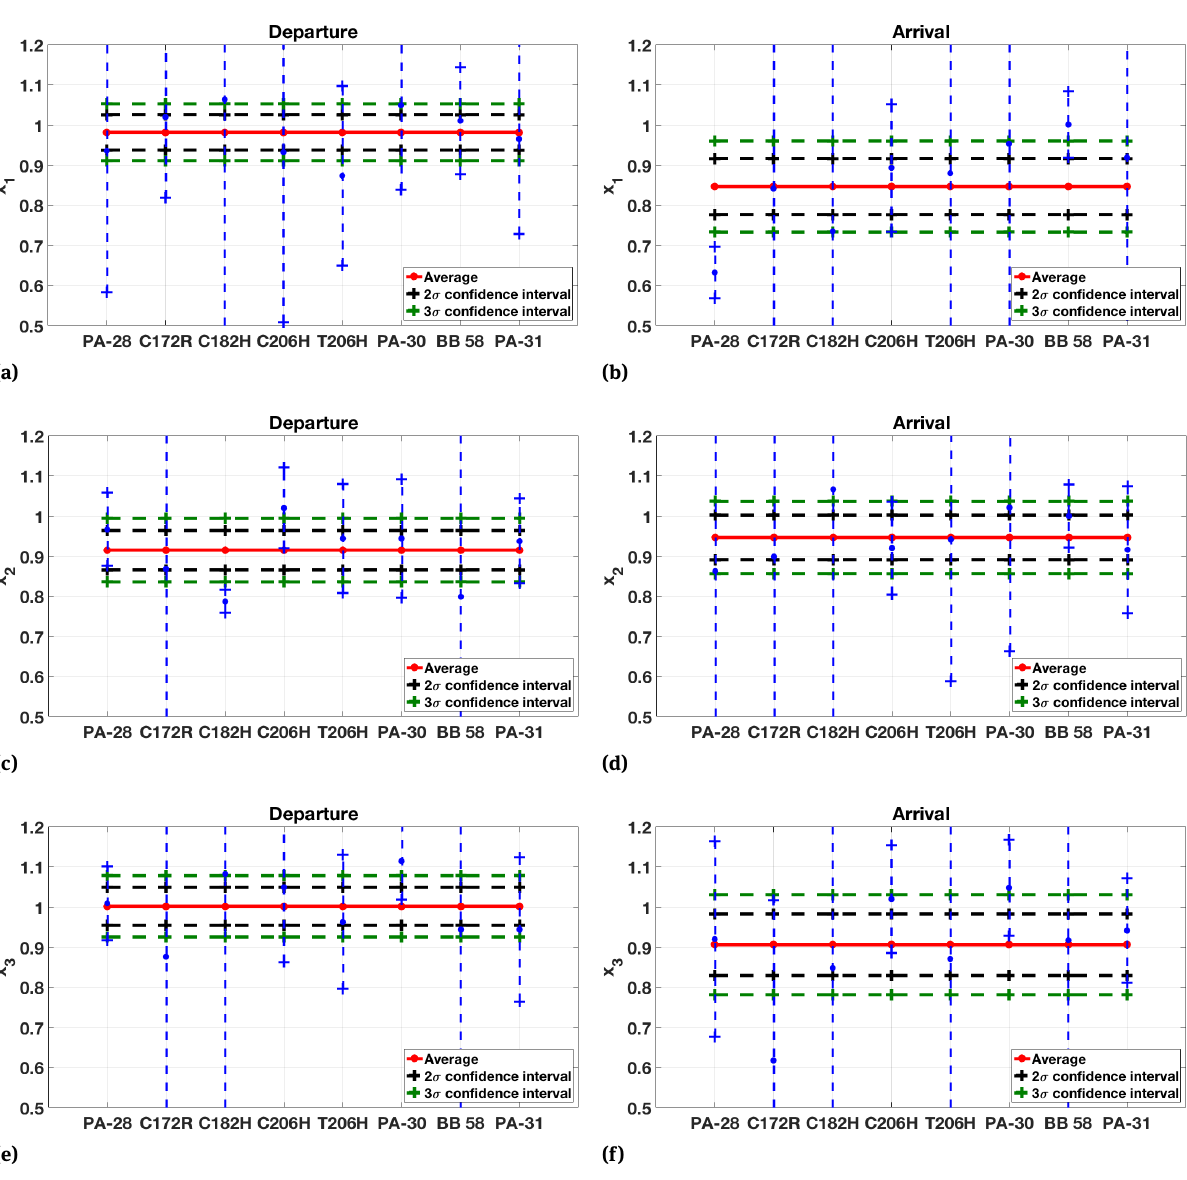
Figure 3: Statistical analysis of blending coeflcients. (a,b) airframe coeflcient. (c,d) propeller coeflcient. (e,f) engine coeflcient. (a,c,e) departure conditions. (b,d,f) arrival conditions. Blue vertical bars: results from coeflcients designed considering only a specific aircraft. Horizontal bars: results obtained from coeflcients designed considering all aircraft